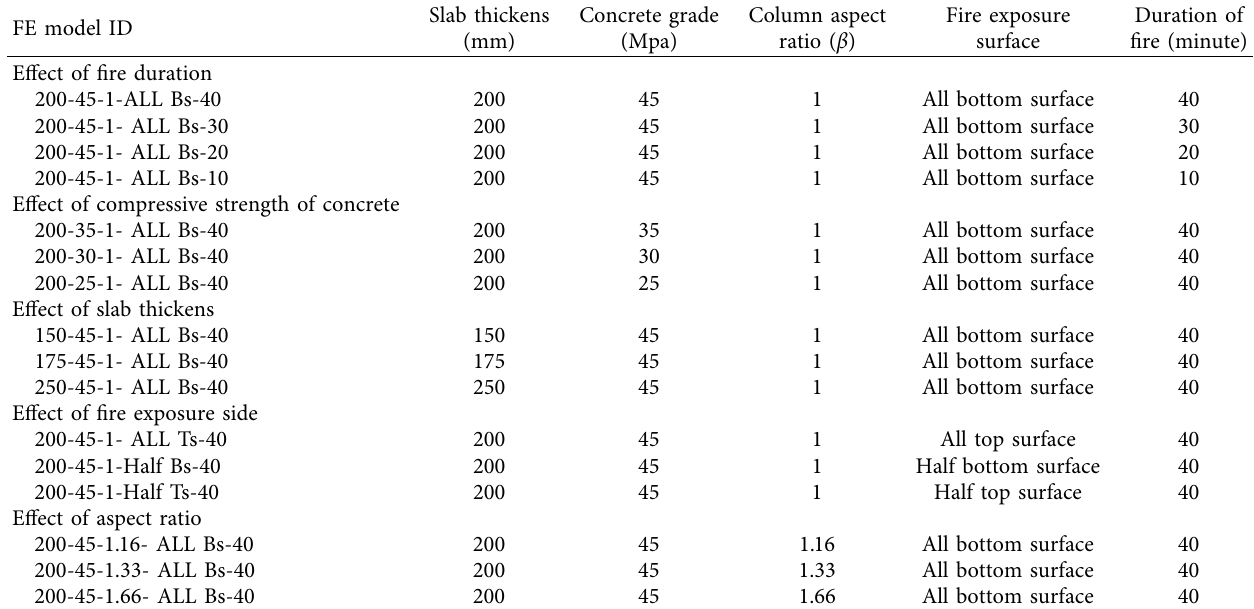
Figure 19: Variation of modulus of elasticity of reinforcement with temperature [19]. Table 4: Parametric study matrix table of GFRP-reinforced slab-column connection with shear reinforcement under post-earthquake